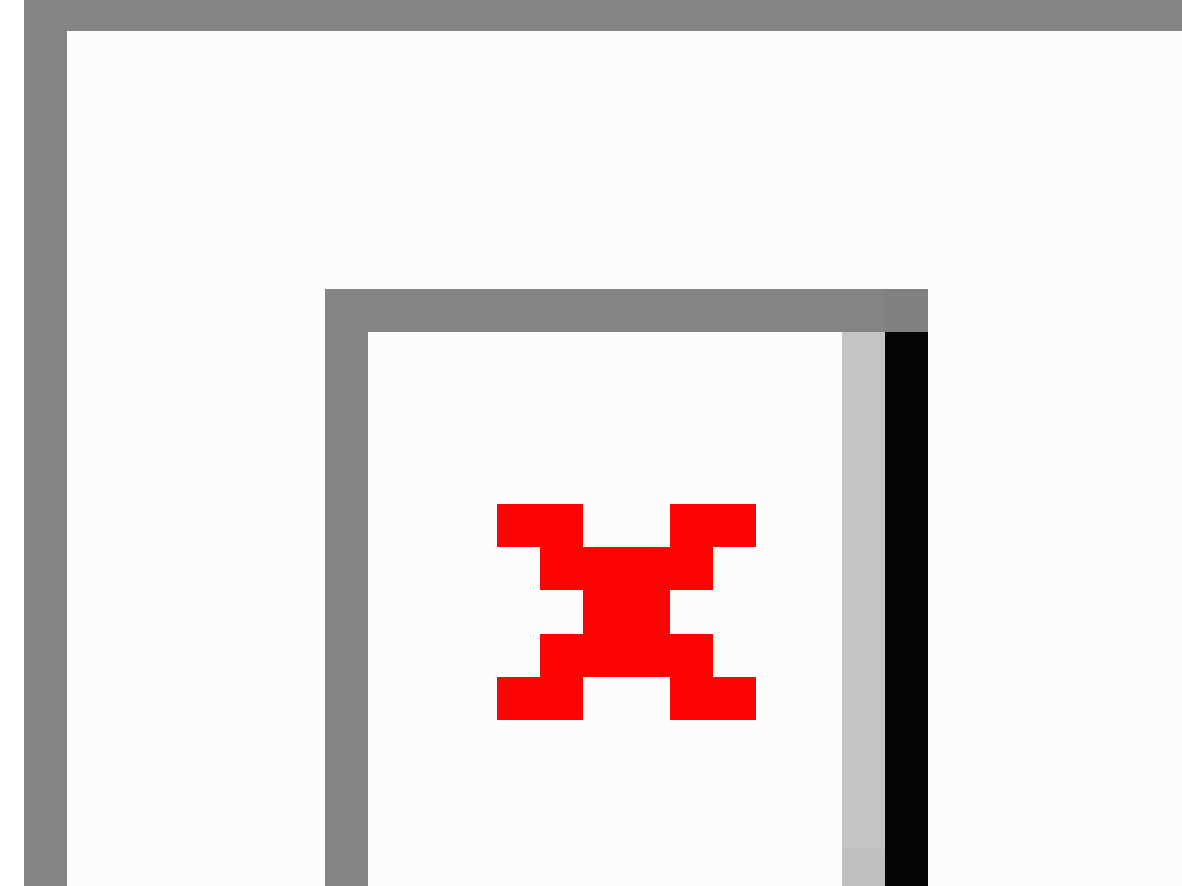
Figure 1. Screenshot of "Teen Video Clips" (short, animated role model stories) showing titles of topics addressed in the online behavior change